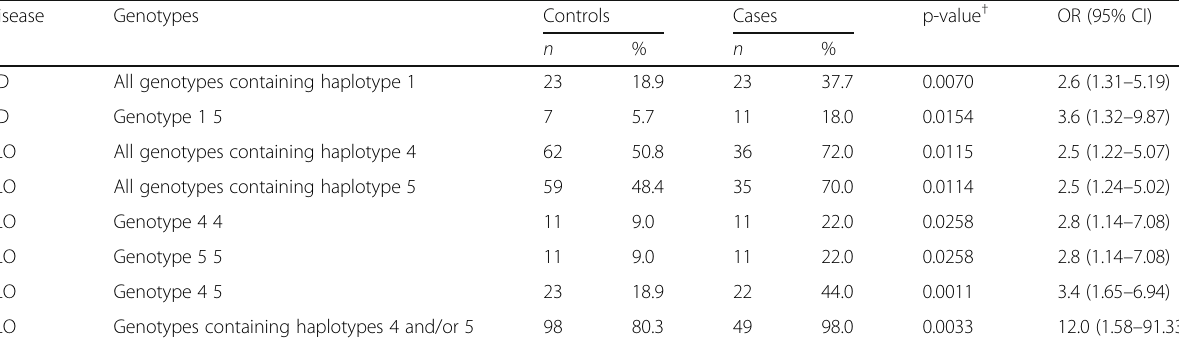
(Additional file 4: Table S4). Haplotype 3 was more Table 3 DLA class II genotypes significantly associated with Addison ’ s disease (AD) and symmetrical lupoid onychodystrophy (SLO) in 233 Bearded collies, and corresponding odds ratios (OR) with the 95% confidence interval (CI) using the DLA haplotype